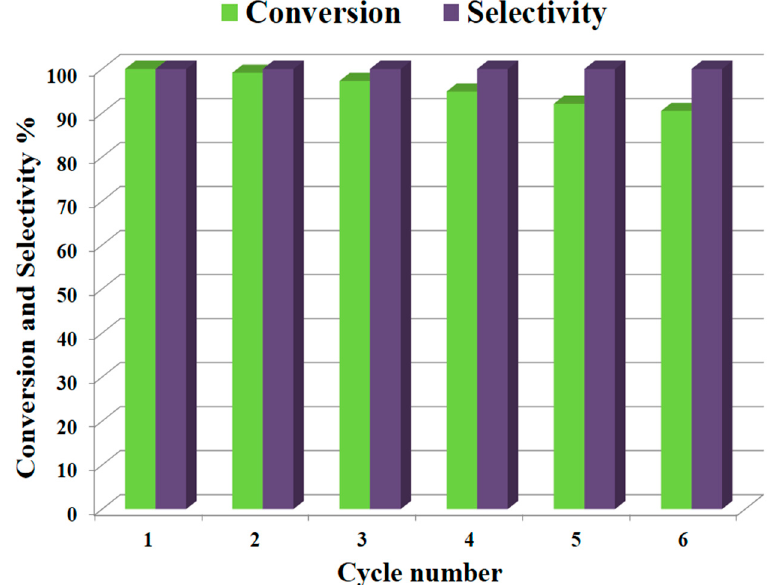
Figure 11. Reusability of (1%)Ag 2 O–MnO 2 / (5 wt.%)GRO catalyst for BnOH oxidation, Conditions: